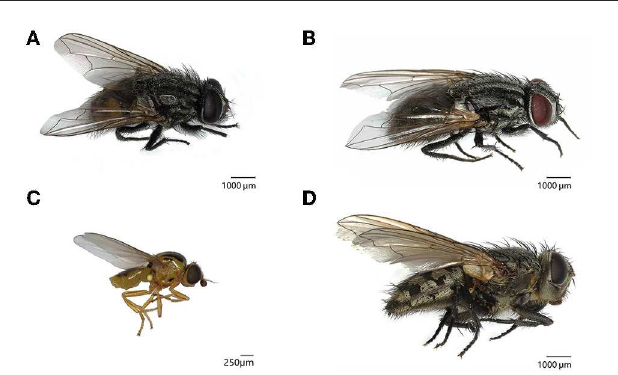
FIGURE1 Fly species hibernating in water towers in Flanders, Belgium. (A) Musca autumnalis or face flies (6–10mm) have a gray to dark gray thorax with four longitudinal thoracic stripes. The compound eyes of the male are close together and the abdomen is black with yellow to orange lateral patches. (B) The female face fly has compound eyes with a wider vertex and the abdomen is mottled black and gray. (C) Thaumatomyia notata or yellow swarming flies are small, yellow flies (2.5–3.5mm) with dark stripes on the thorax. (D) Cluster flies are members of the genus Pollenia and are characterized by golden brown hairs on the